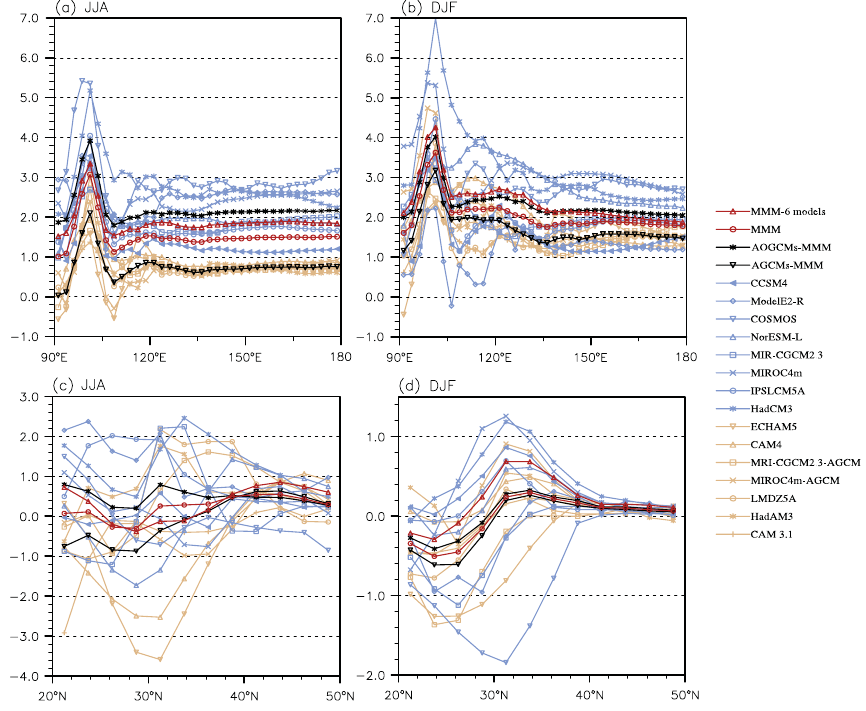
Fig. 9. The seasonal SAT (top, units: ◦ C) and precipitation differences (bottom, units: mmday − 1 ) between mid-Pliocene and pre-industrial experiments. The SAT changes are meridionally averaged within 10–40 ◦ N. The precipitation changes are zonally averaged within 105– 120 ◦ E.